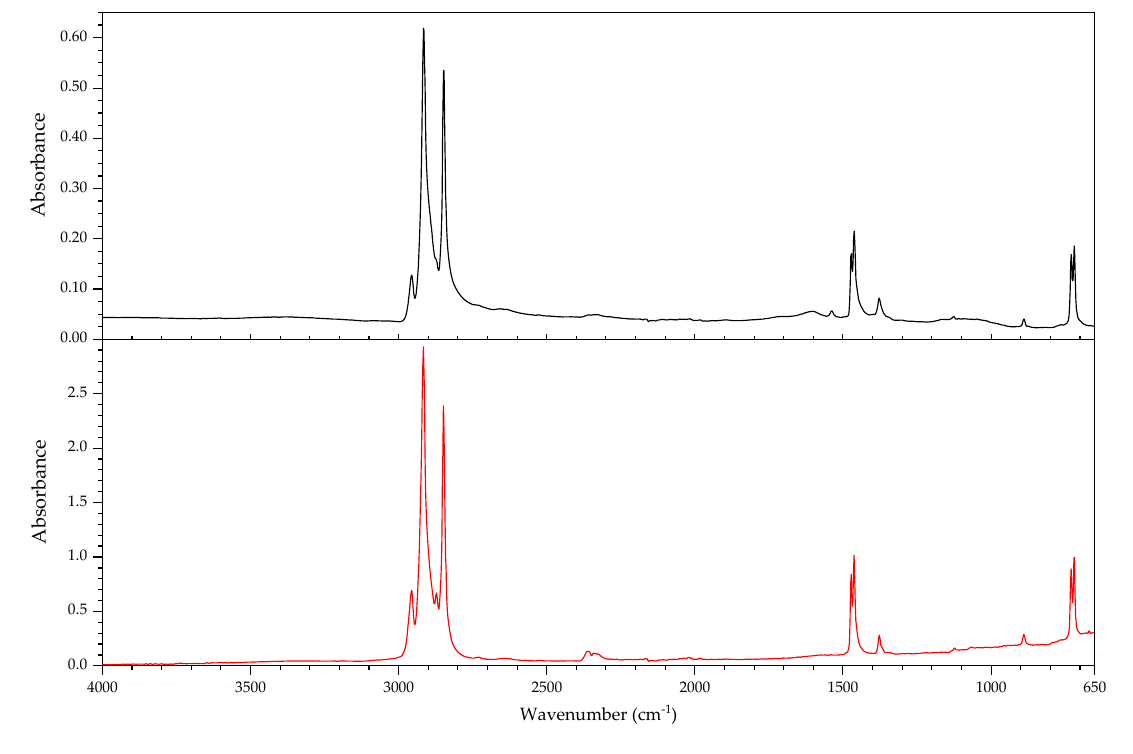
Figure 24. FTIR spectrum of the blooming of sample 2223-2 (black line) compared to reference spectrum of a mineral wax (paraffin, red line) from a commercial database.